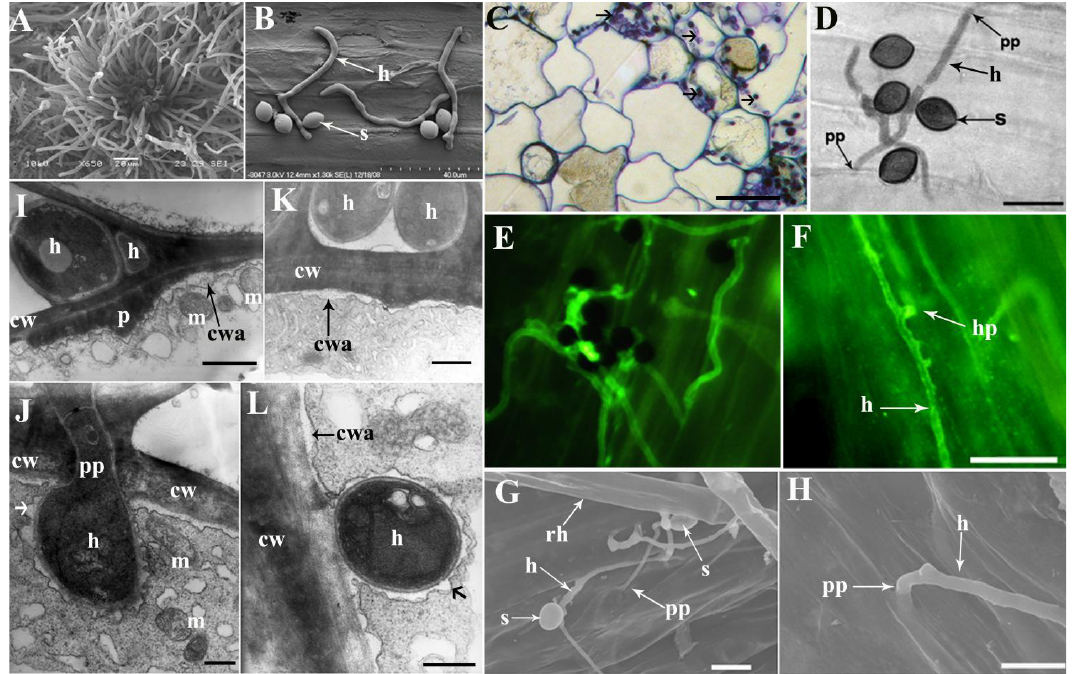
Figure 2. Infection and colonization of C. globosum strain ND35 in cucumber radicle. Under scanning electron microscopy, ( A ): The morphology of appendage of strain ND35 perithecium; ( B ): The mor- phology of hyphae from germinated ascospores of strain ND35. C-L: Colonization of hyphae of strain ND35 in cucumber radicle. Under light microscopy, ( C ): Several epidermal cells were infected by hyphae (arrowheads) of strain ND35, bars = 10 μm; ( D ): The hyphae of strain ND35 invaded cucumber root from a gap between epidermal cells of the root surface at 20 hpi (arrowheads), bars = 12 μm . ( E – H ): The hyphae developed from germinated germ tube penetrated the radicle from a gap between the epidermal cells at 20 hpi; ( E ) and ( F ): The hyphae of strain ND35 stained with goat anti-rabbit conjugated FITC and viewed with a fluorescence microscope, bars = 20 μm . Under scan- ning electron microscopy, ( G ): The hyphae of strain ND35 penetrated the cucumber from a gap between epidermal cells at 20 hpi, bars = 10 μm; ( H ): The hypha penetrated the epidermis from a gap between epidermal cells at 30 hpi, bars = 5 μm . ( I – L ): TEM imaging of defenses reaction of cucumber radicle cells at contacting or penetration sites and hyphae in outer cortical cells; ( I ): Papilla was formed in the inner wall of the epidermal cell when hyphae of strain ND35 between epidermal cells have contacted the out er wall of epidermal cells at 36 hpi, bars = 1 μm; ( J ): The hypha of strain ND35 penetrated the cell wall into the adjacent cortical cell at 36 hpi, bars = 0.5 μm; ( K ): Cell wall apposition was formed on adjacent cortical cell wall when hyphae have been growing in intercellu- lar space contacting cell wall, bars = 0.5 μm; L: The hypha of strain ND35 in cortical cells were sur- rounded by the amorphous matrix (arrowheads), bars = 0.5 μm. cw: cell wall, cwa: cell wall apposi- tion, m: mitochondrion, h: hypha, hp: hyphopodia, p: papilla, pp: penetration point, rh: root hair, s: spores of strain ND35.